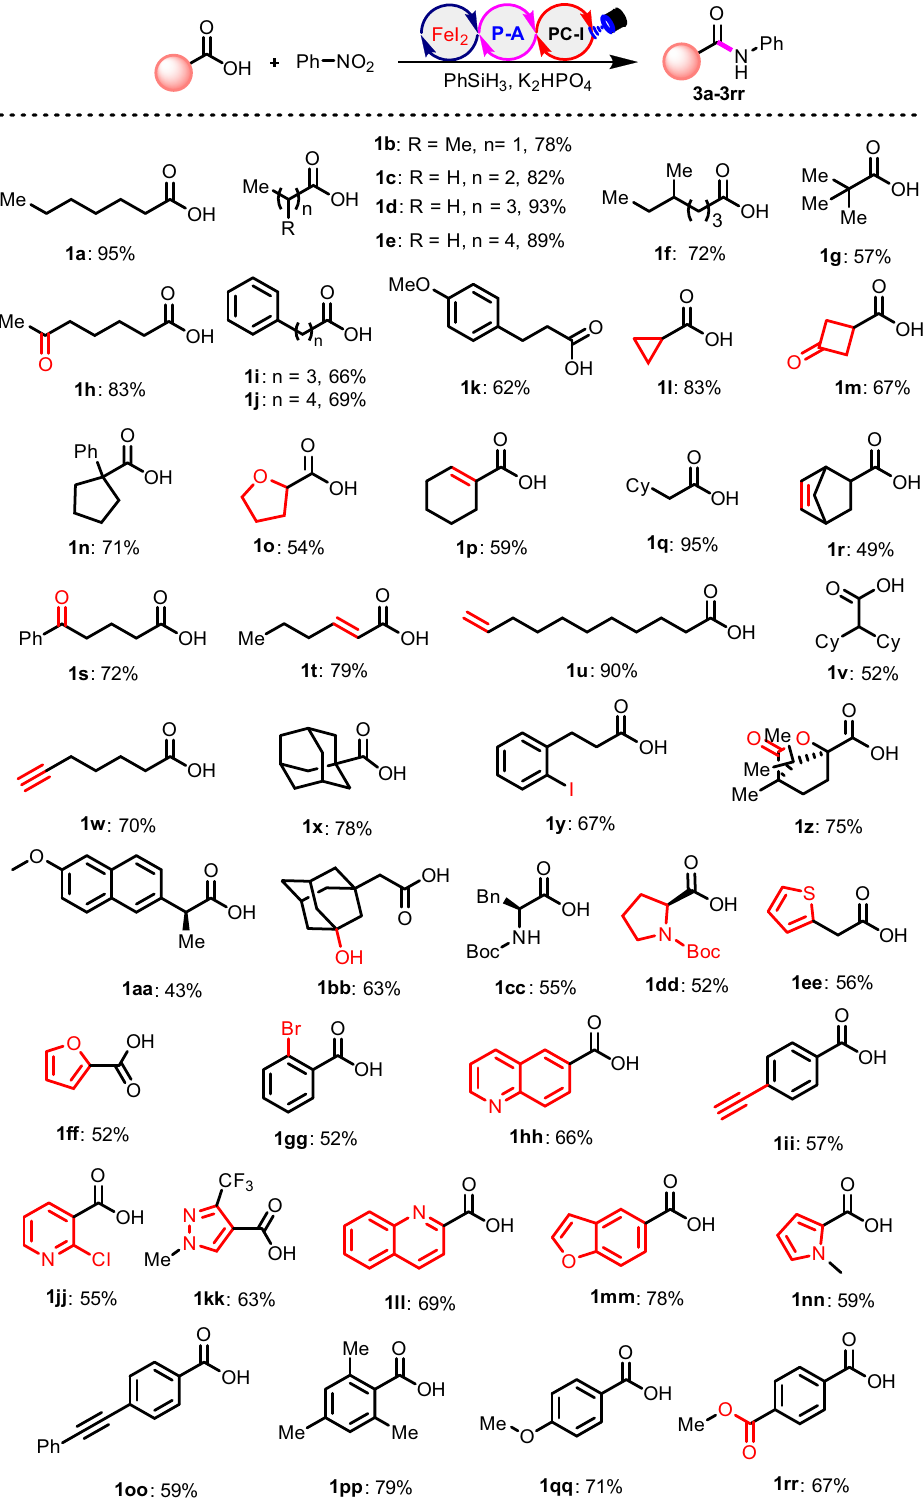
Fig. 2 The scope of carboxylic acids. Standard conditions: carboxylic acids 1 (0.2 mmol), 2a (1.2 equiv), PC-I (1 mol%), P-A (30 mol%), FeI 2 (15